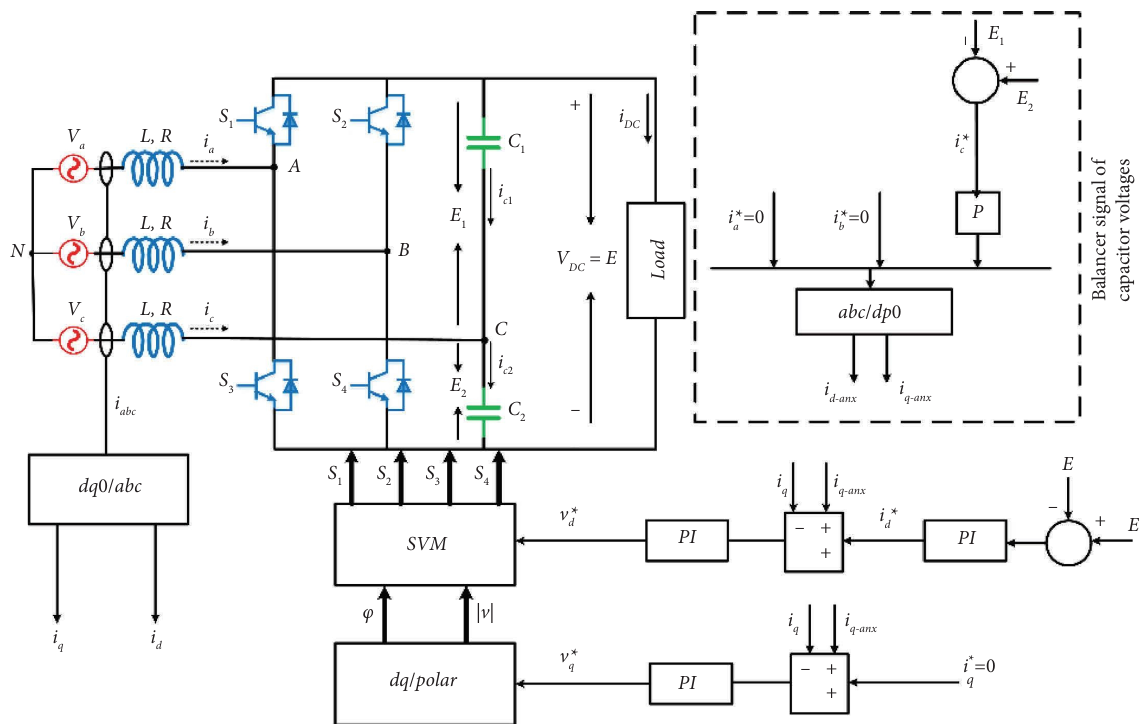
Figure 3: Block diagram of the conventional controller for